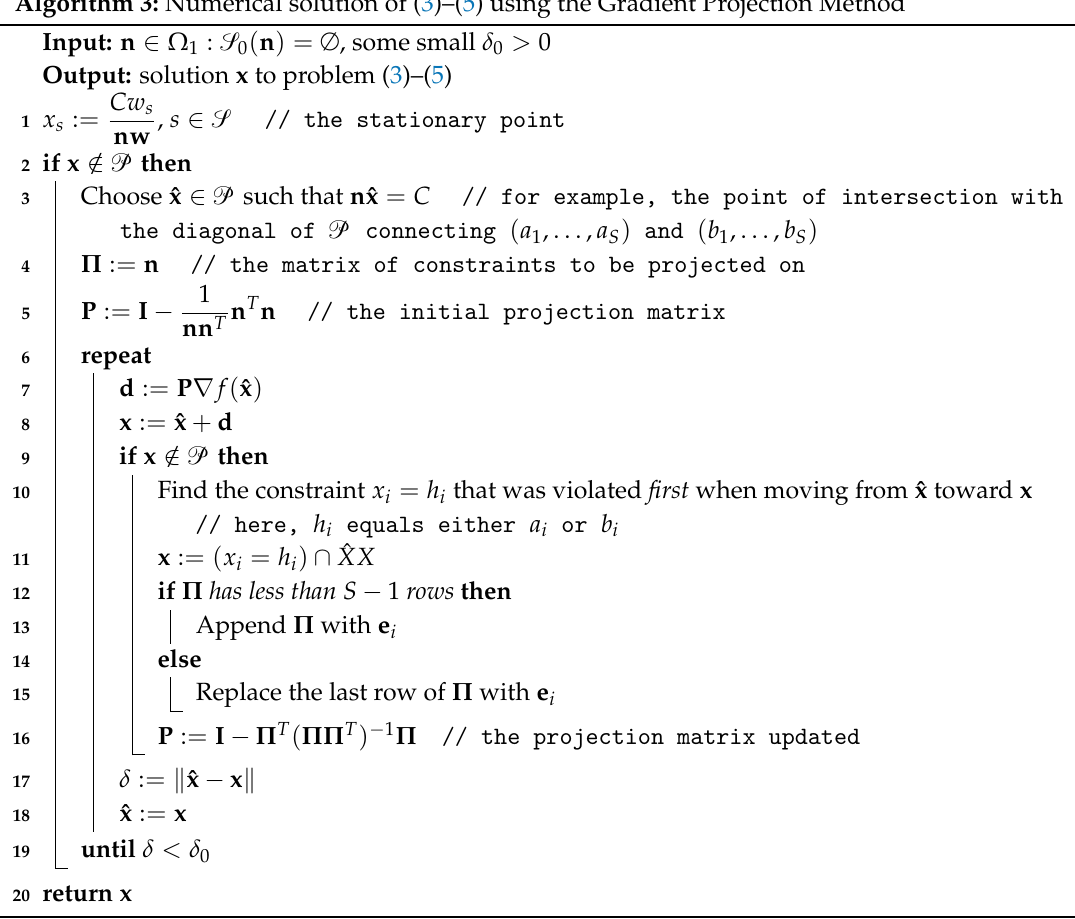
Algorithm 3: Numerical solution of (3)–(5) using the Gradient Projection